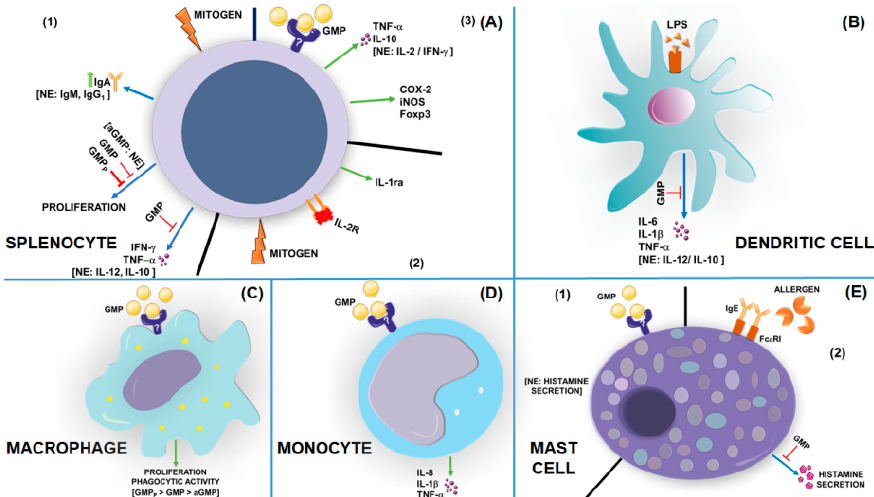
Figure 4. Effect of glycomacropeptide on immune cell function determined from in vitro assays. Glycomacropeptide (GMP) regulates the response of splenocytes, dendritic cells, macrophages, monocytes, and mast cells in different